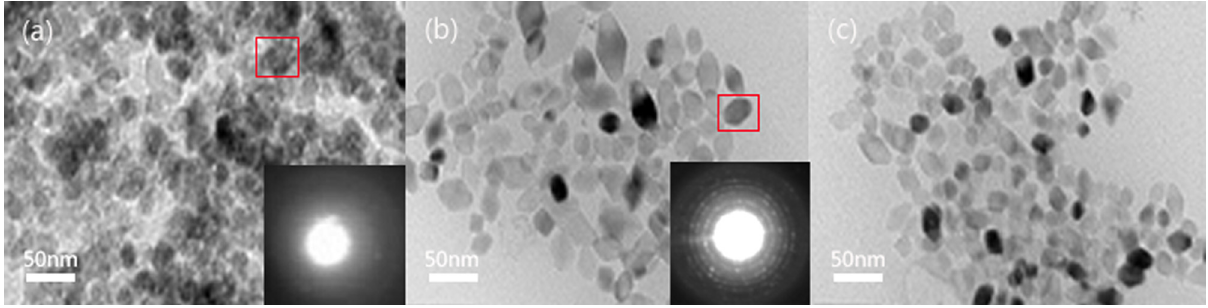
Figure 2: TEM pictures of TiO 2 synthesized at 30 MPa and di ff erent temperatures ( a ) 300°C, right corner – SAED picture obtained from red frame ( b ) 400°C, right corner – SAED picture obtained from red frame ( c ) 500°C as 0.04 M Ti ( SO 4 ) 2 being precursor and 0.16 M KOH was added.